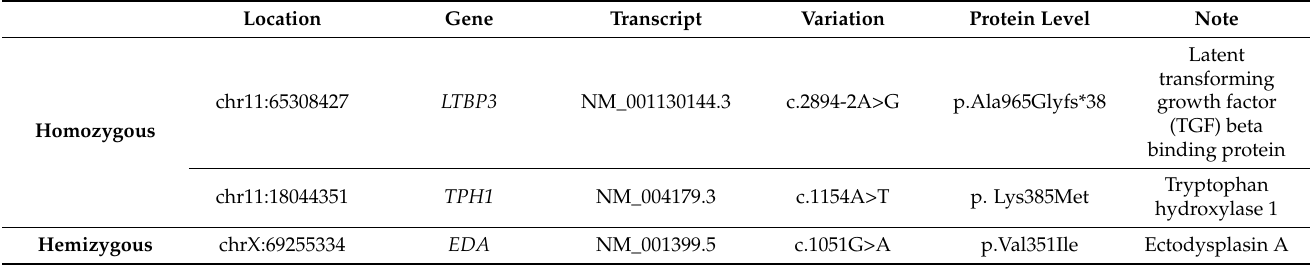
Table 1. Identified variants by WES analysis.